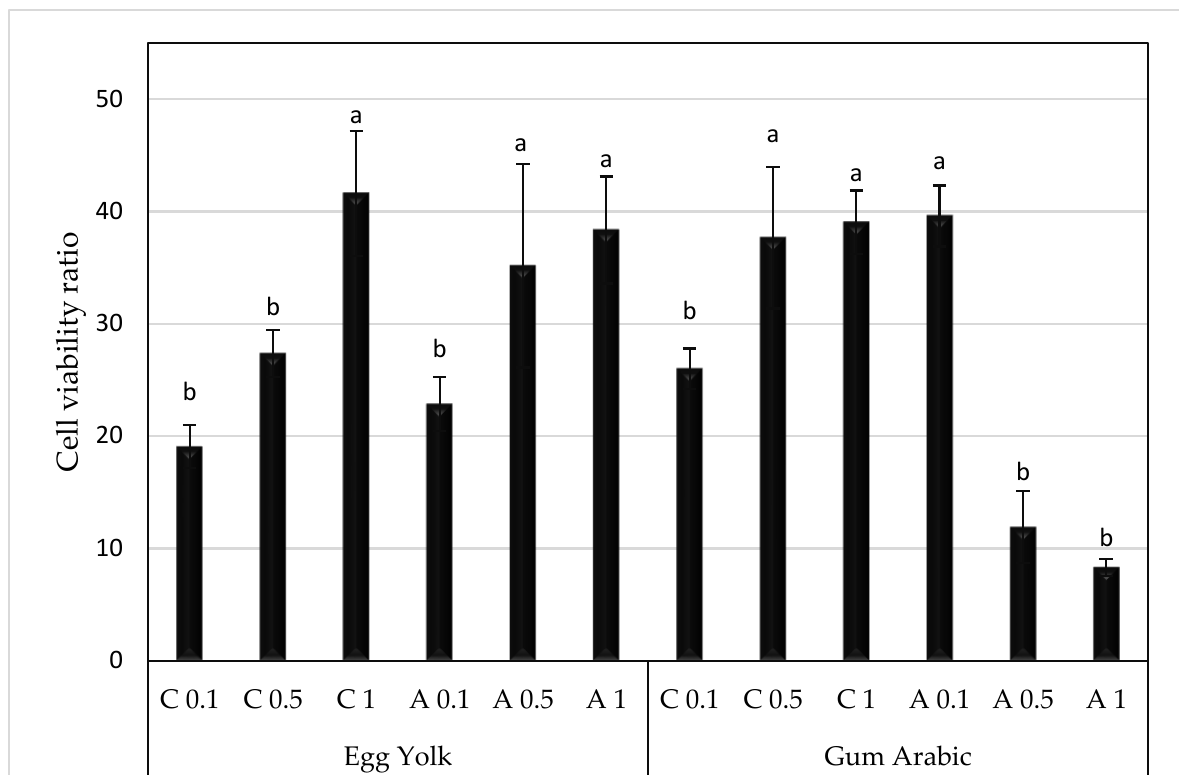
Figure 5. Mean ± SEM of cell viability after adding cysteine or ascorbic acid to egg yolk or gum arabic extenders for ram spermatozoa postcryopreservation. C: cyctein (mM); A: ascorbic acid (mM). a,b bars bearing different superscript letters are significantly different from one another ( p < 0.05).